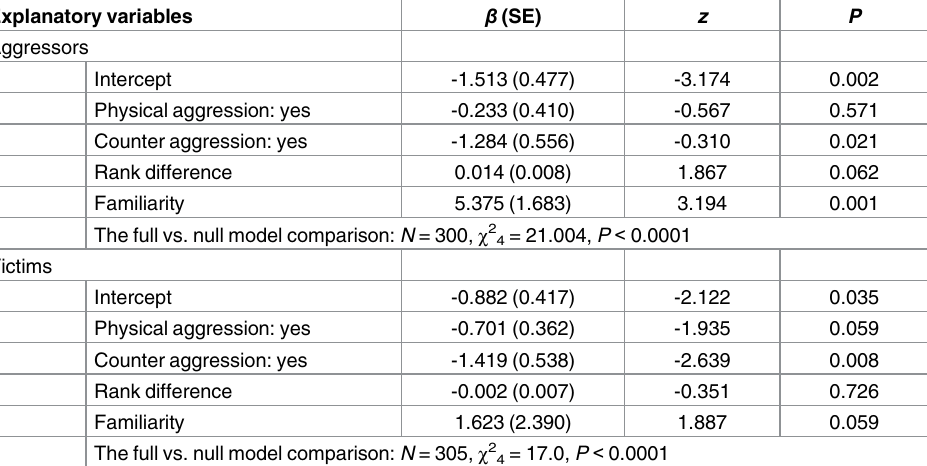
Table 2. GLMM logistic regression results for the factors affecting the occurrence of post-conflict interactions with the former opponent. Explanatory